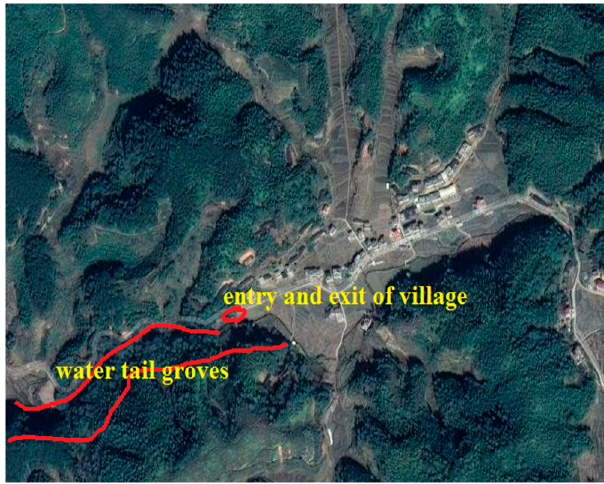
Figure A3. Geographical features of Dongshang Village.